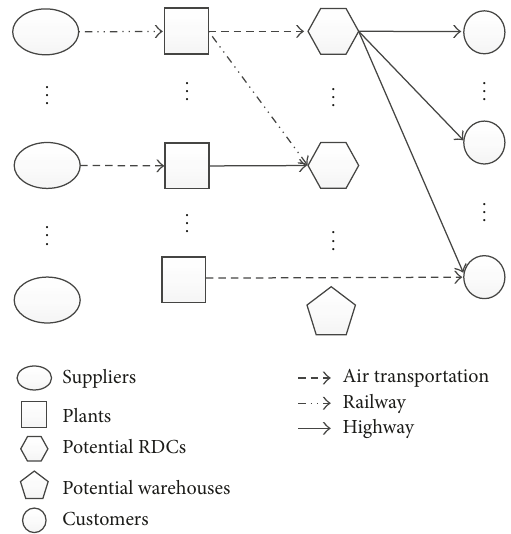
Figure 1: Representation of the four-level supply chain